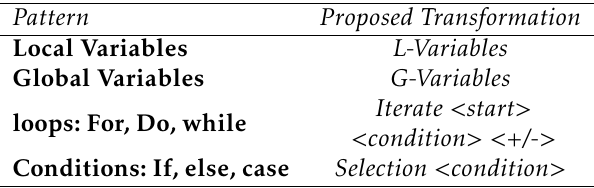
Table 1. Normalization and Abstraction